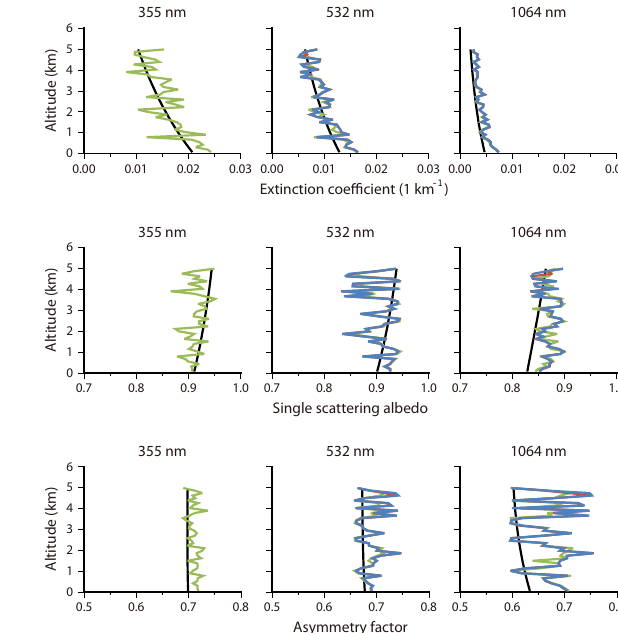
Figure 7. Same as Fig. 5 but showing the retrieval results from the simulated data with random errors for the continental average